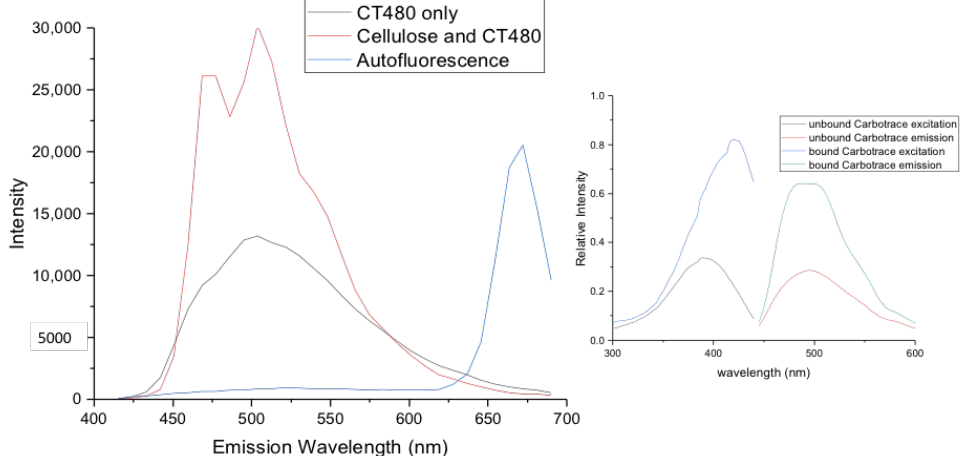
Figure 2. Confocal Laser Microscopy emission spectra of unbound CT480, bound CT480 to pure cellulose, defibrillated cellulose autofluorescence, and their comparison to the reference spectra provided by Ebba biotech—right side